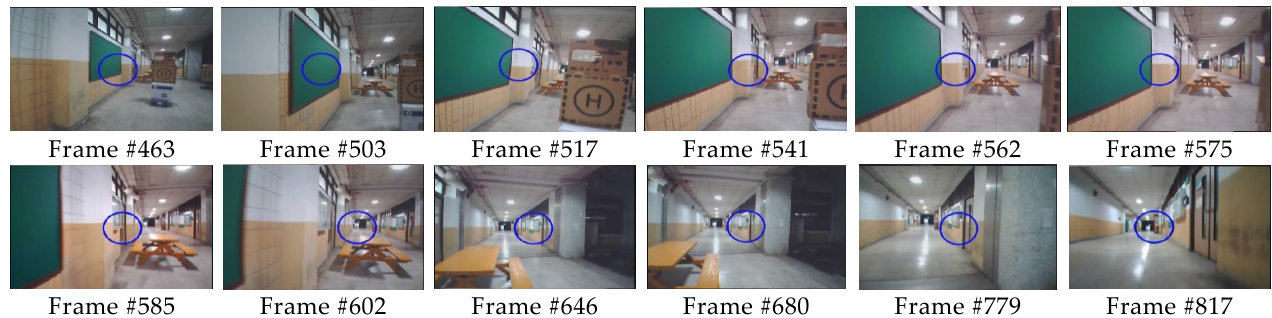
Figure 10. Obstacle avoidance of MUAV. The image sequence is recorded from the camera on MUAV. The blue circle represents the desired flight direction in the image frame.